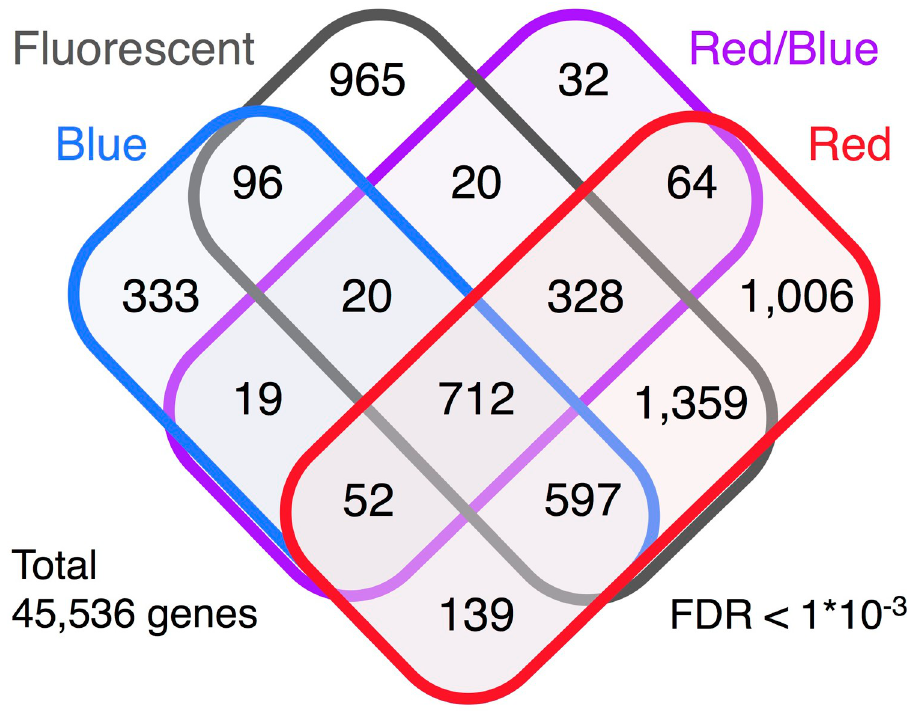
Fig 4. Four-set Venn diagram of the DEGs. The numbers of DEGs with FDR < 1 � 10 − 3 in comparisons of the young and old leaves of the plants grown under the different light source conditions are shown.